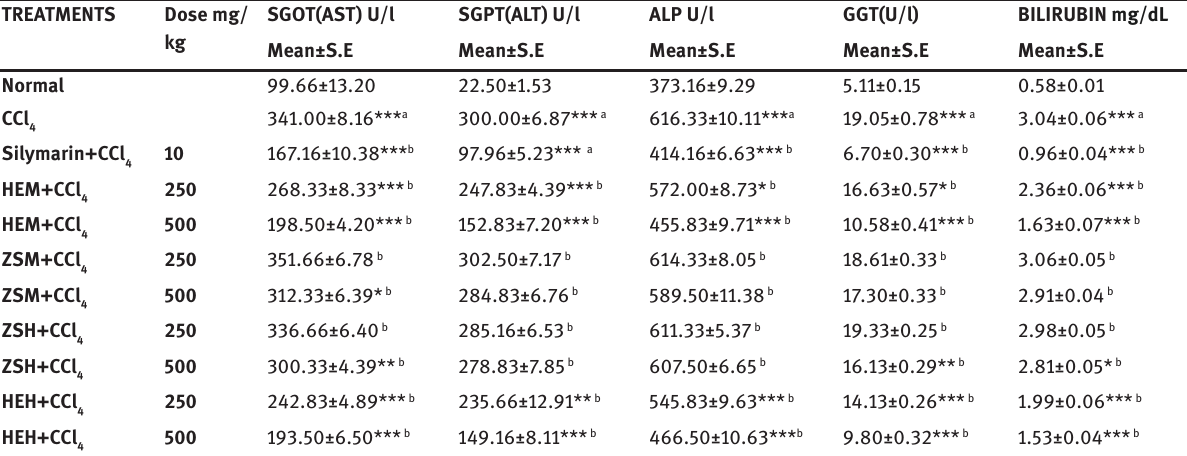
Table 1: Effect of Extracts on serum marker enzymes of control and treated rats.